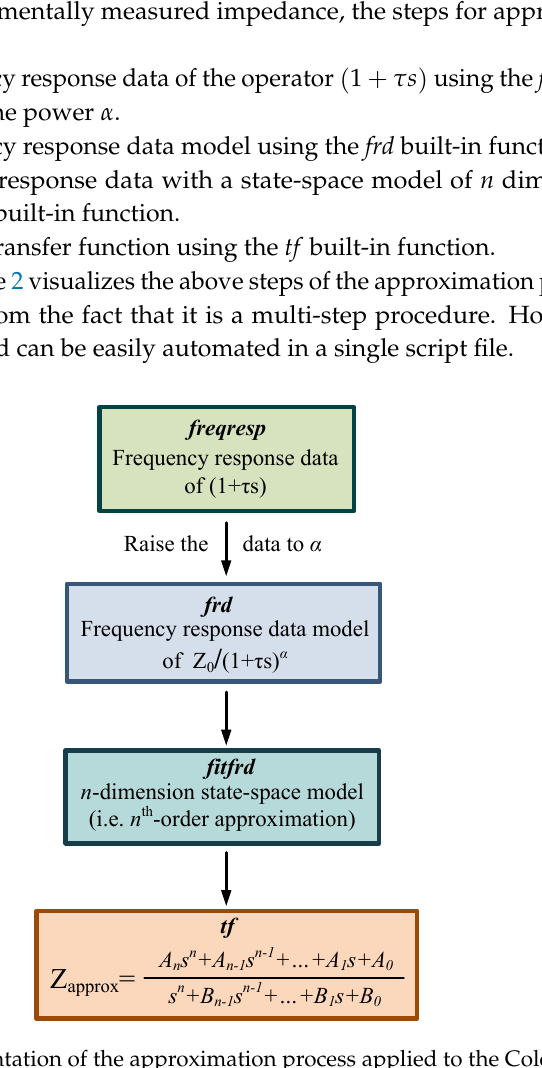
Figure 2. Schematic representation of the approximation process applied to the Cole–Davidson